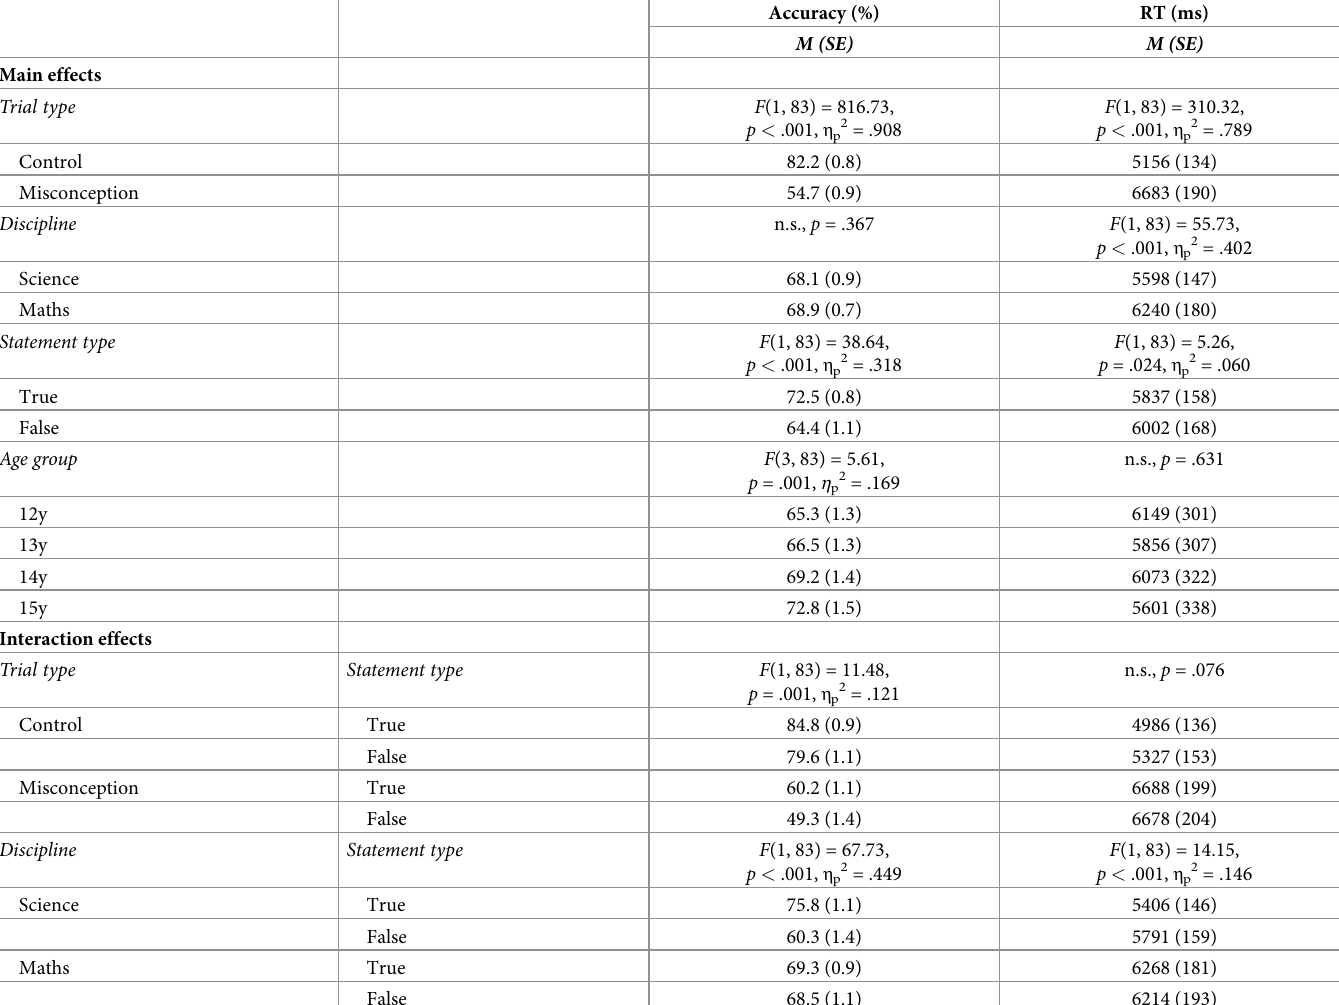
Table 2. Accuracy and RT estimated marginal means in the science and maths misconceptions